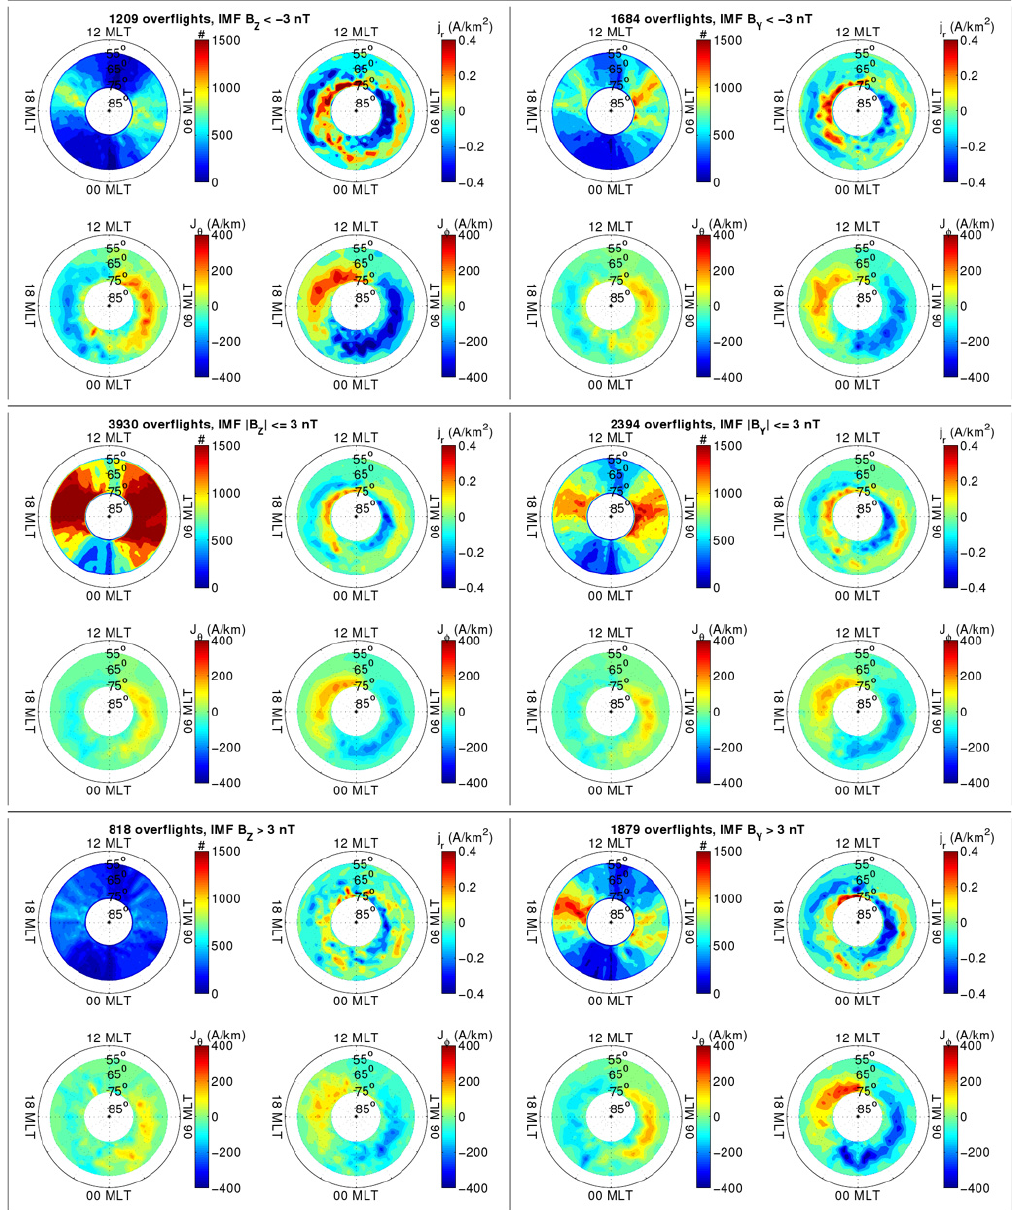
Fig. 10. Current components J r (FAC), J θ and J φ as function of magnetic latitude and MLT, binned with respect to the IMF BZ and BY. There are bins for negative ( < 3 nT), around zero ( < | 3 | nT) and positive ( > 3nT) values of both components. The bin and the number of overpasses used to construct the four plots are denoted on top of each set. Resolution of the plots is 0.5h in MLT and 1 ◦ in latitude. Top left plot of each panel shows the distribution of CHAMP measurements in the data set. Reproduced from Fig. 12 of Juusola et al.